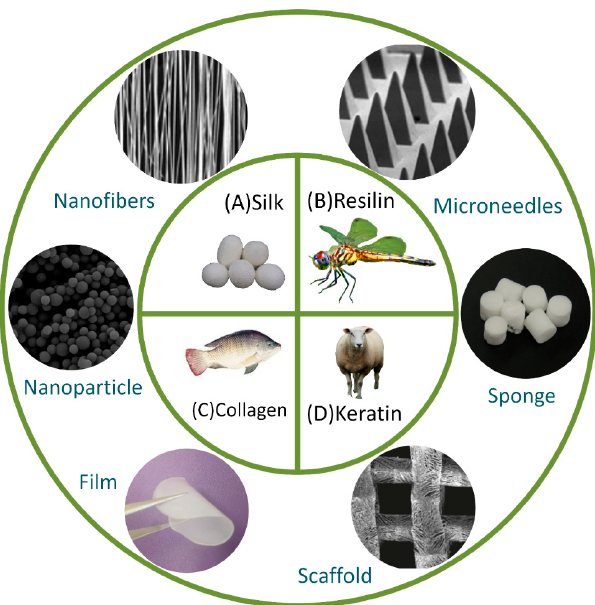
Figure 1. Various proteins and their possible sources under research for drug-delivery applications: ( A ) silk from Bombyx mori cocoons; ( B ) resilin from dragonfly; ( C ) collagen from fish scales; ( D ) keratin from goat hairs. These proteins can be fabricated into various drug-delivery vehicles such as films, sponges, gels, fibers, nanoparticles and microneedles. (Reproduced with permission